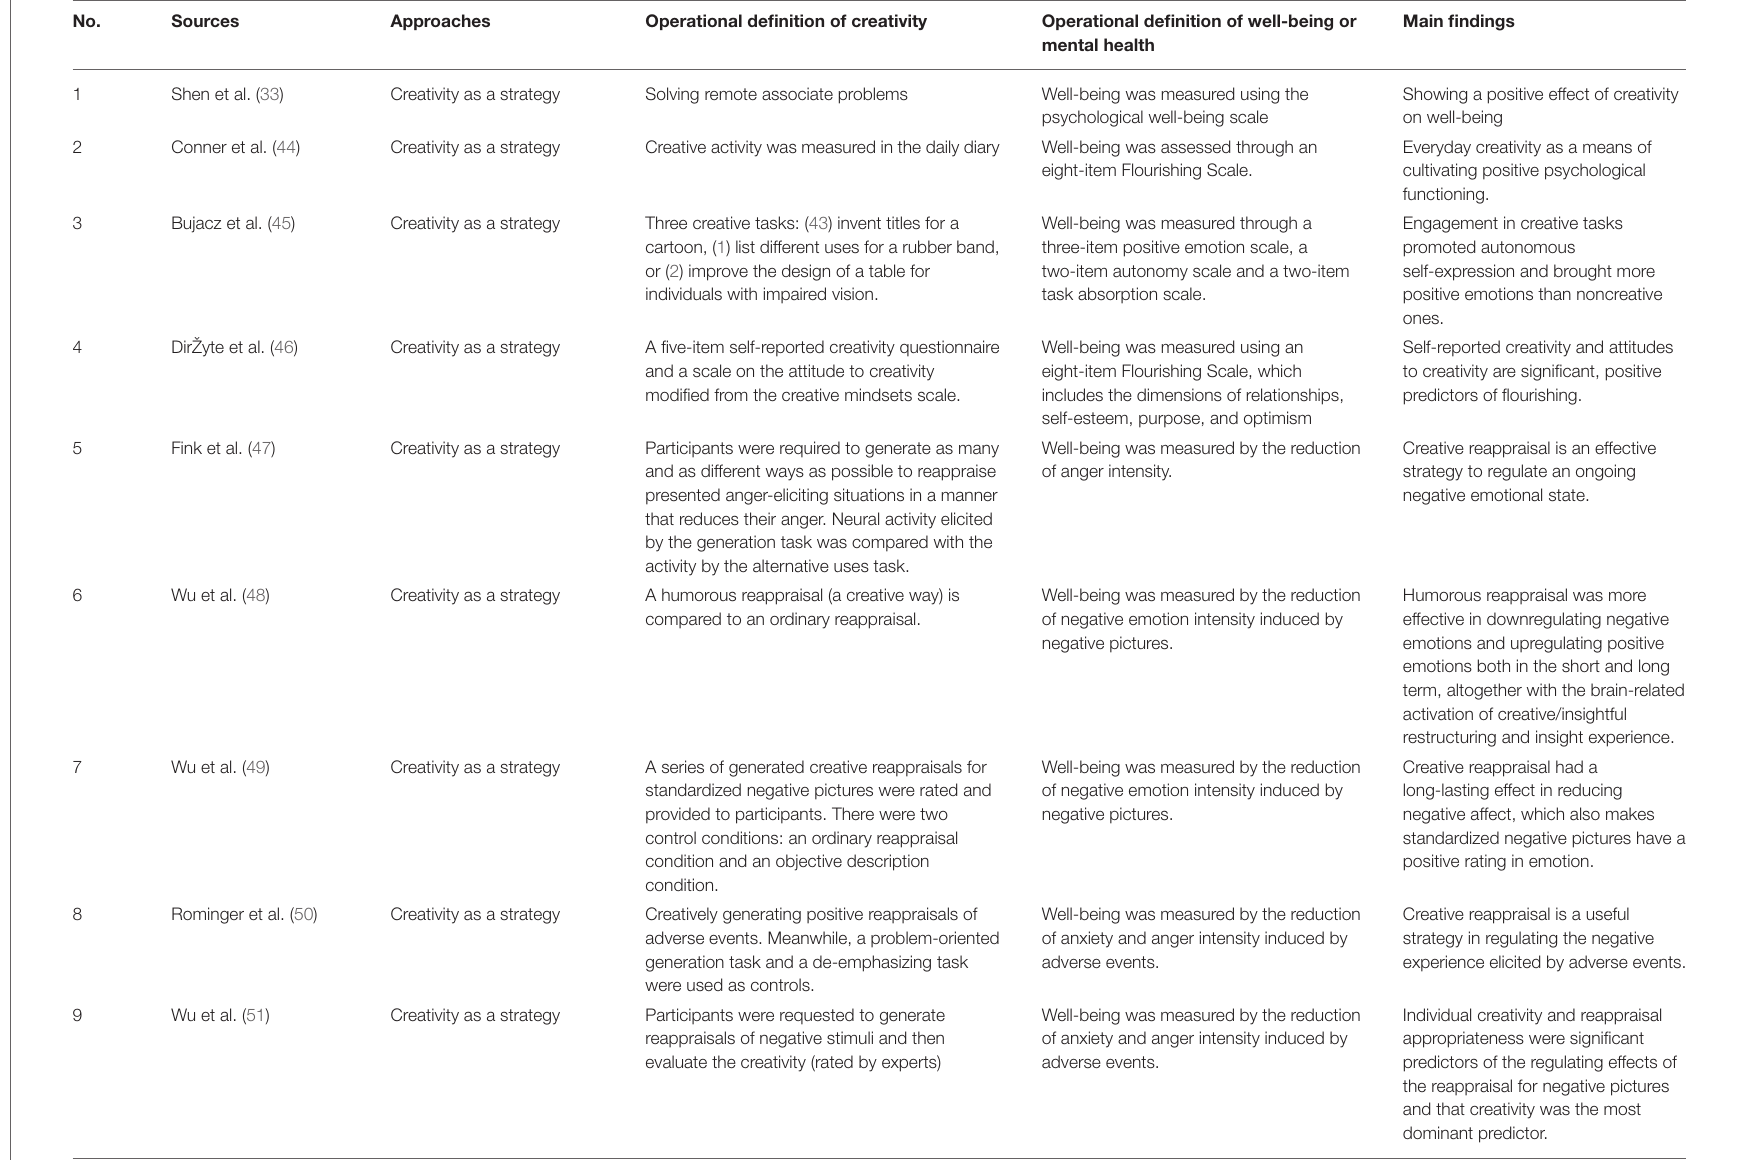
TABLE 1 | Example studies supporting the dichotomous link between creativity and mental health.